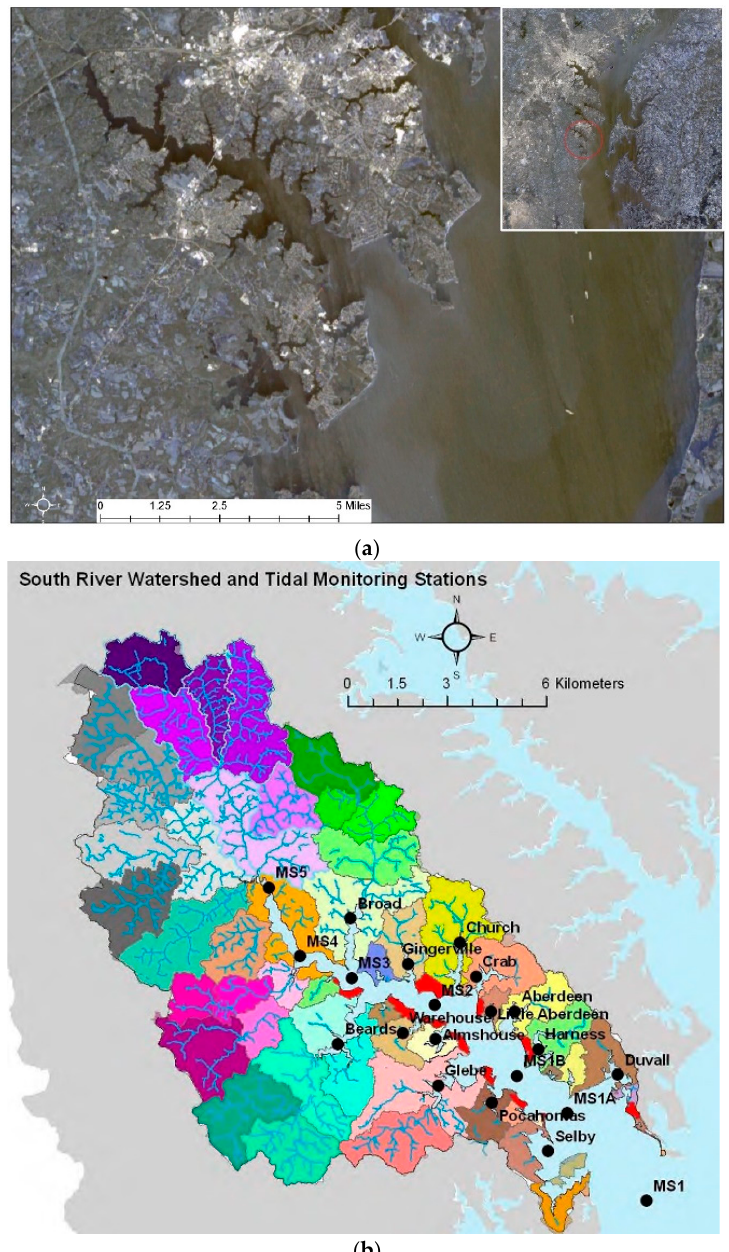
Figure 1. ( a ) Location of the South River Estuary on the western shore of Chesapeake Bay, Maryland, USA. ( b ) Location of the research sites with the main stem and triblet stations.